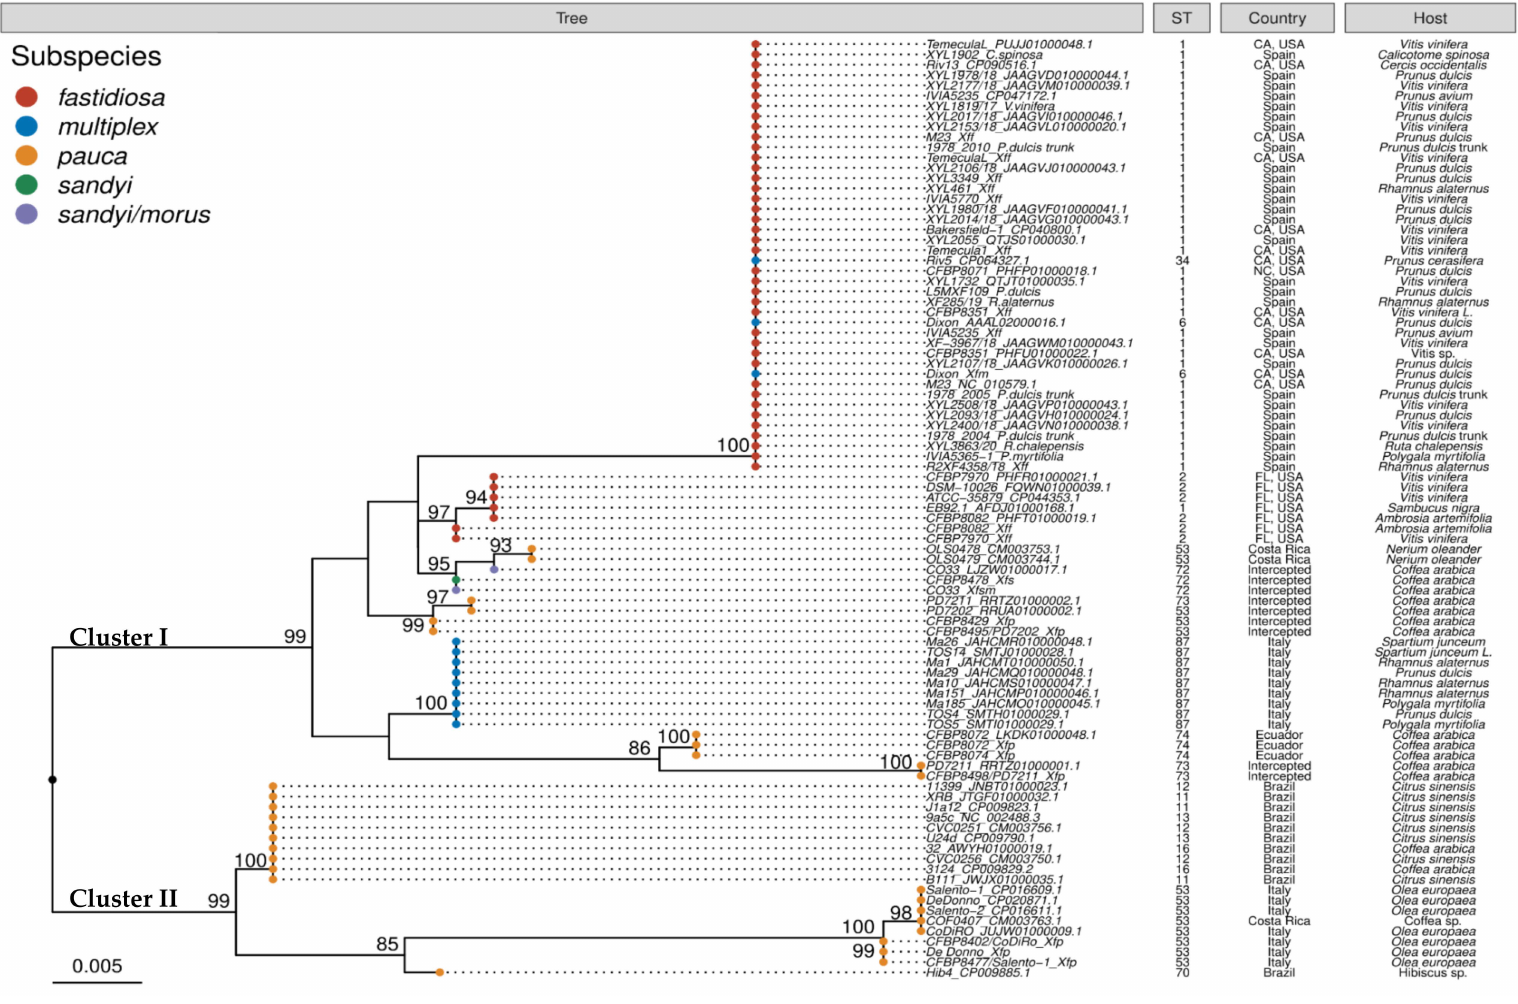
Figure 2. Maximum-likelihood phylogeny showing the genetic relationships among traC gene amplified from different Xylella fastidiosa strains and naturally-infected plants from this study and from drafts or finished whole-genomes of Xf present in the GenBank database. The numbers on the branches indicate the values of the bootstrap